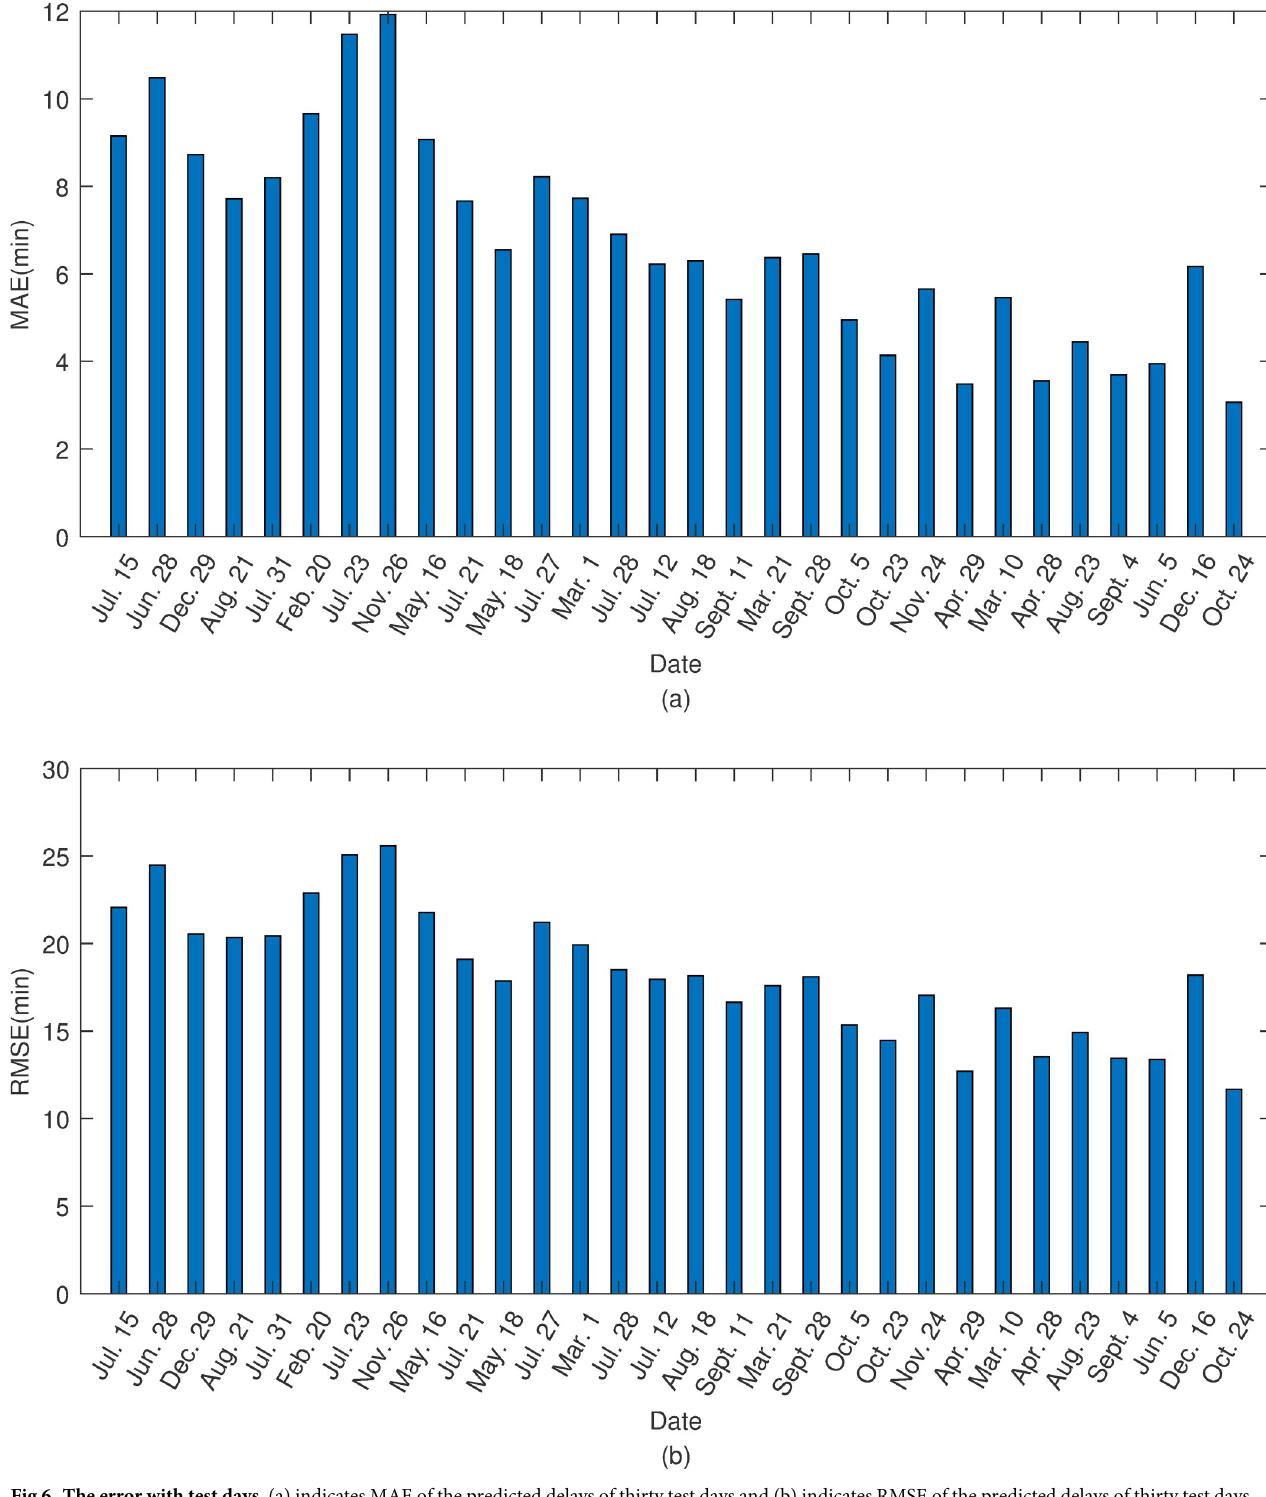
Fig 6. The error with test days. (a) indicates MAE of the predicted delays of thirty test days and (b) indicates RMSE of the predicted delays of thirty test days.